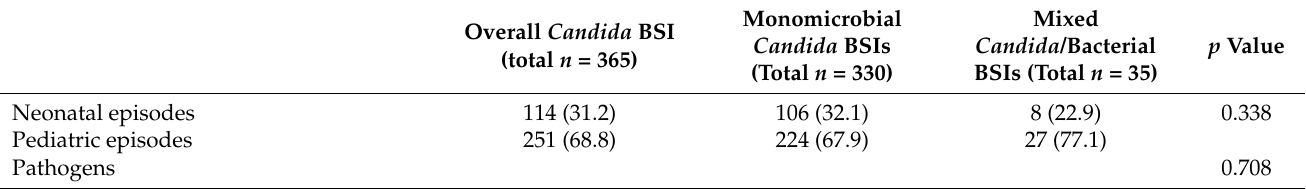
Table 2. Comparisons of monomicrobial Candida bloodstream infections (BSIs) and mixed Can- dida /bacterial BSIs in CGMH,